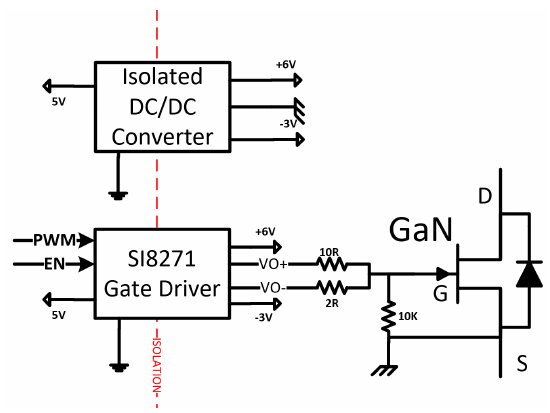
Figure 5. Gate drive block diagram of a GaN